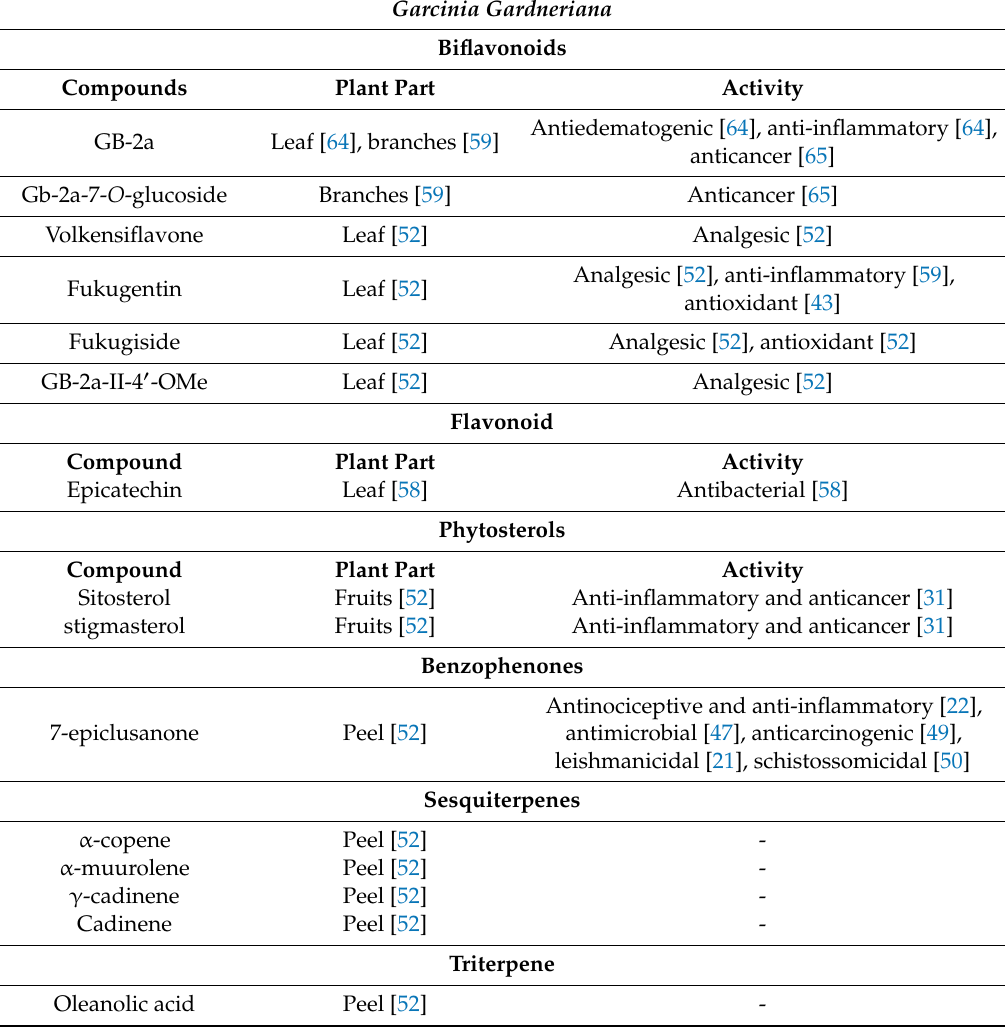
Table 2. List of compounds presented in di ff erent parts of Garcinia gardneriana and related